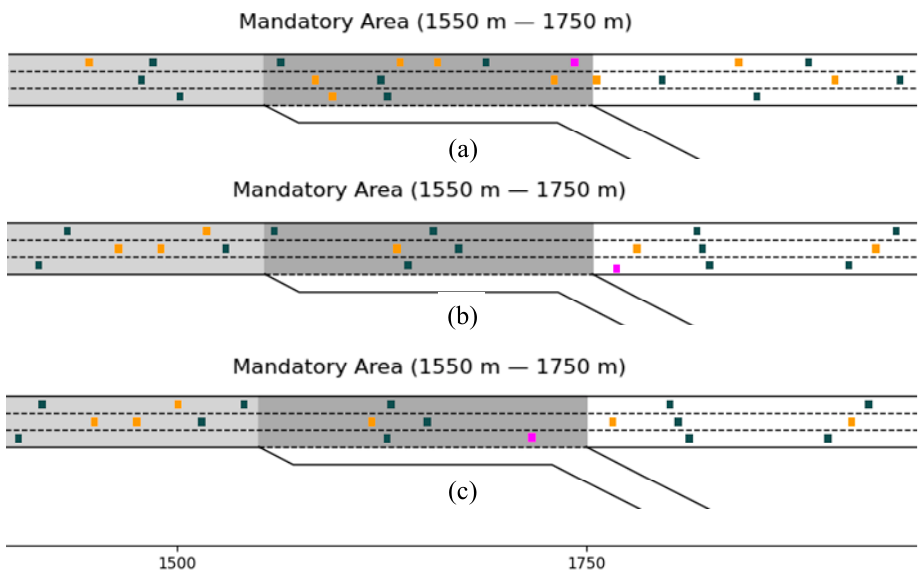
Figure 9. “Aggressive Driver” lane-changing simulation scenario. ( a ) and ( b ) are the “Aggressive Drivers” who failed to drive away from the diverging area, and ( c ) is the “Aggressive Driver” who succeeded.